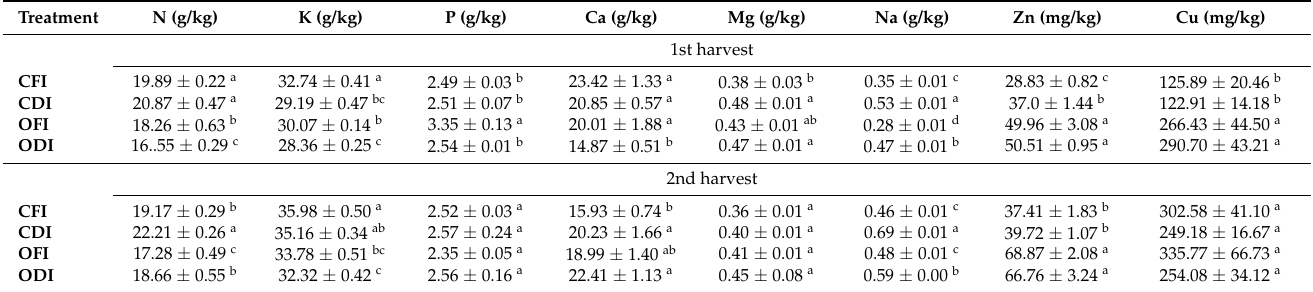
Table 5. Mineral composition of the aerial parts of Melissa officinalis plants grown in conventional (C) or organic (O) cultivation systems and subjected to full (FI) or deficit (DI)